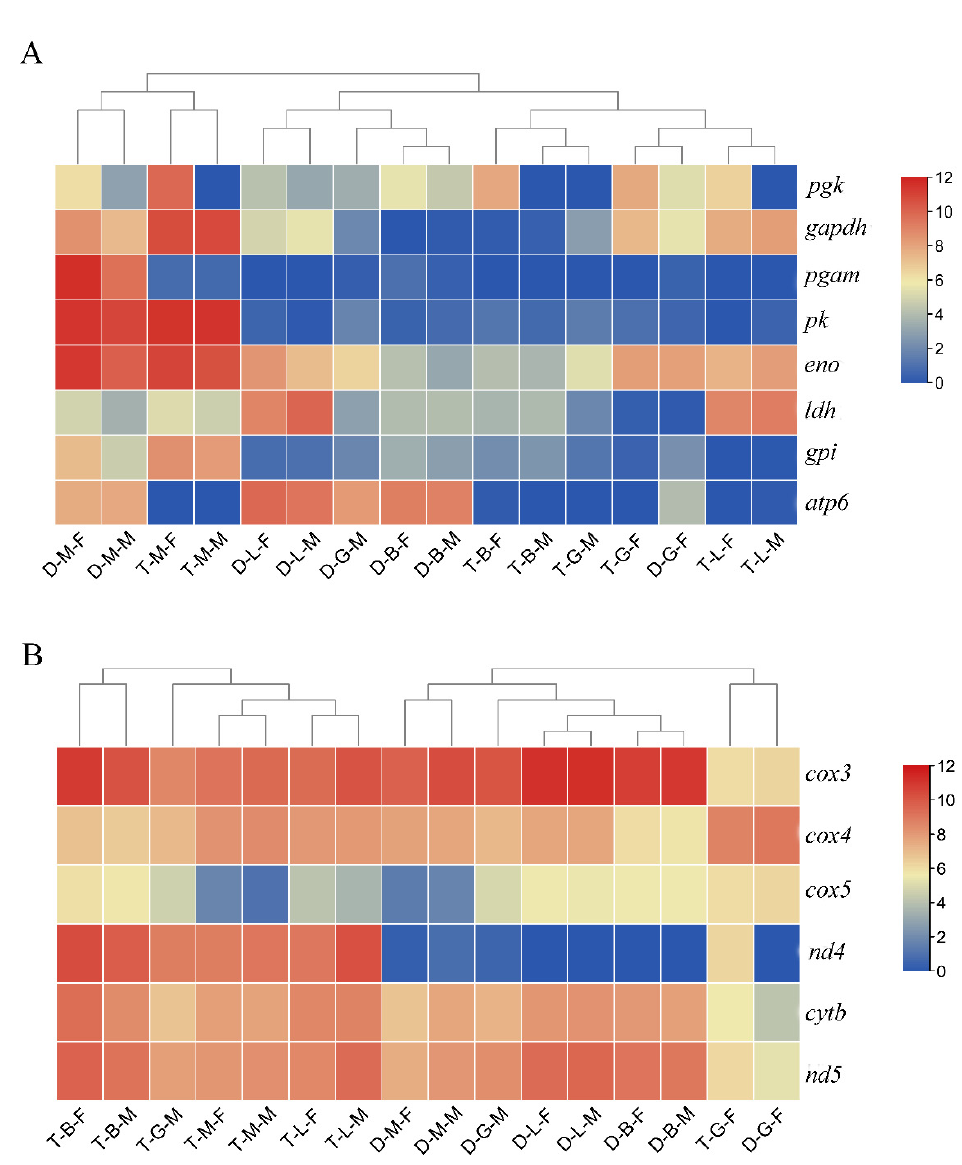
Figure 6. Heat-maps of the key genes related to growth regulation in M. anguillicaudatus. ( A ) The heat-map of the key genes related to glycolysis in each group. ( B ) The heat-map of the key genes related to oxidative phosphorylation pathway in each group.